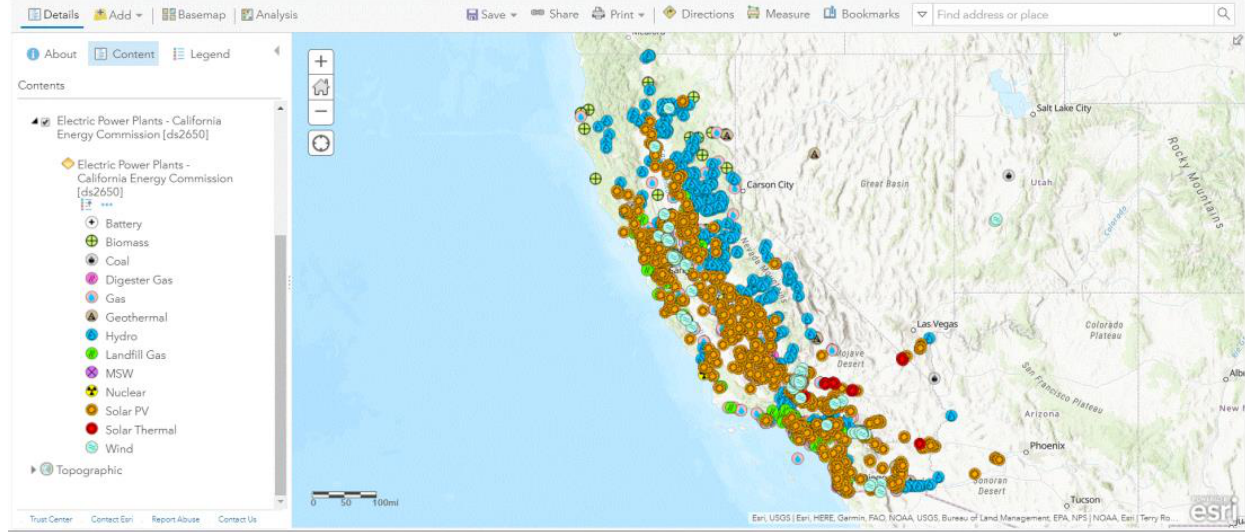
Figure 2. California Energy Commission Layer displayed via the JHU ARCGIS online application [29–31]. From 2014 to 2018, the California instate supply grew on average 0.63% year to